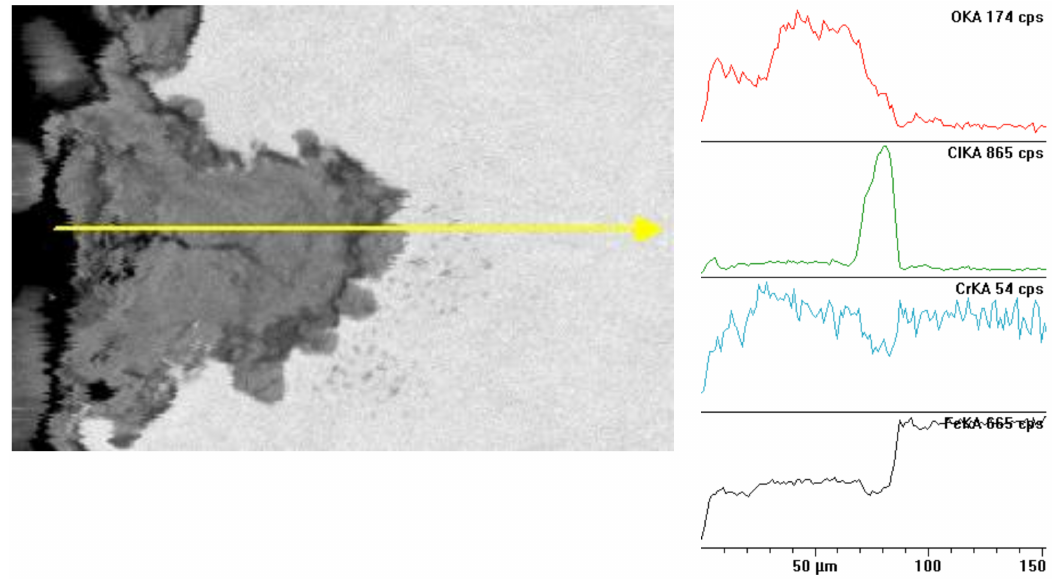
Figure 7. Cross section and linear cross scan of the elements in L80-1 steel at 95 ◦